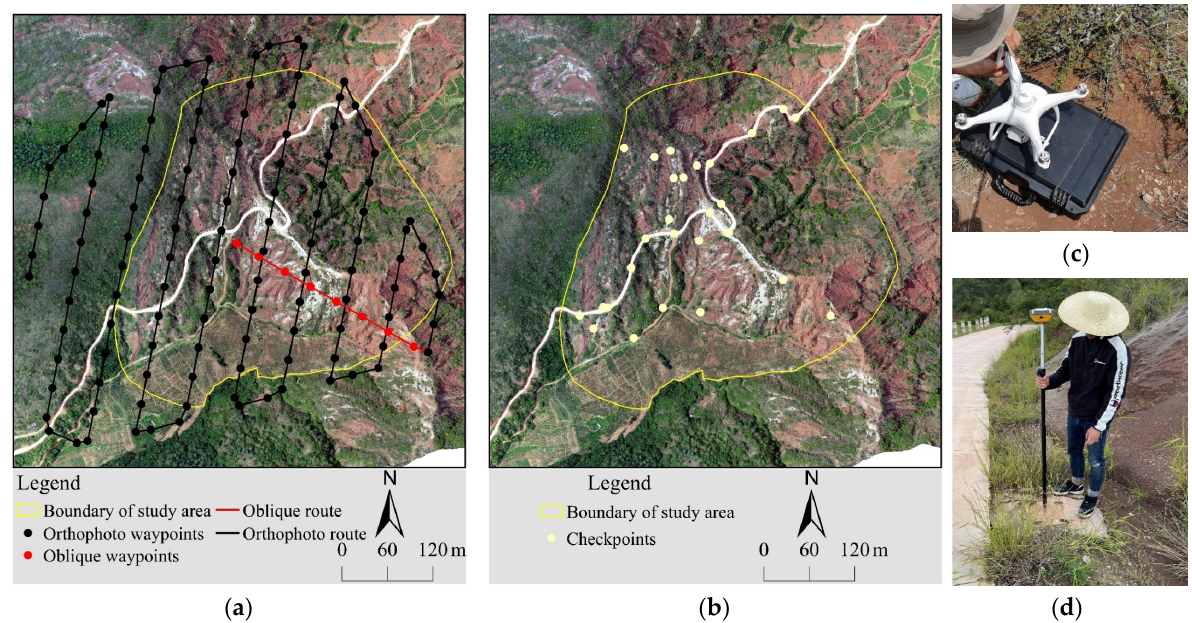
Figure 3. ( a ) UAV flight routes; ( b ) Location of checkpoints; ( c ) UAV type; ( d ) RTK data acquisition.